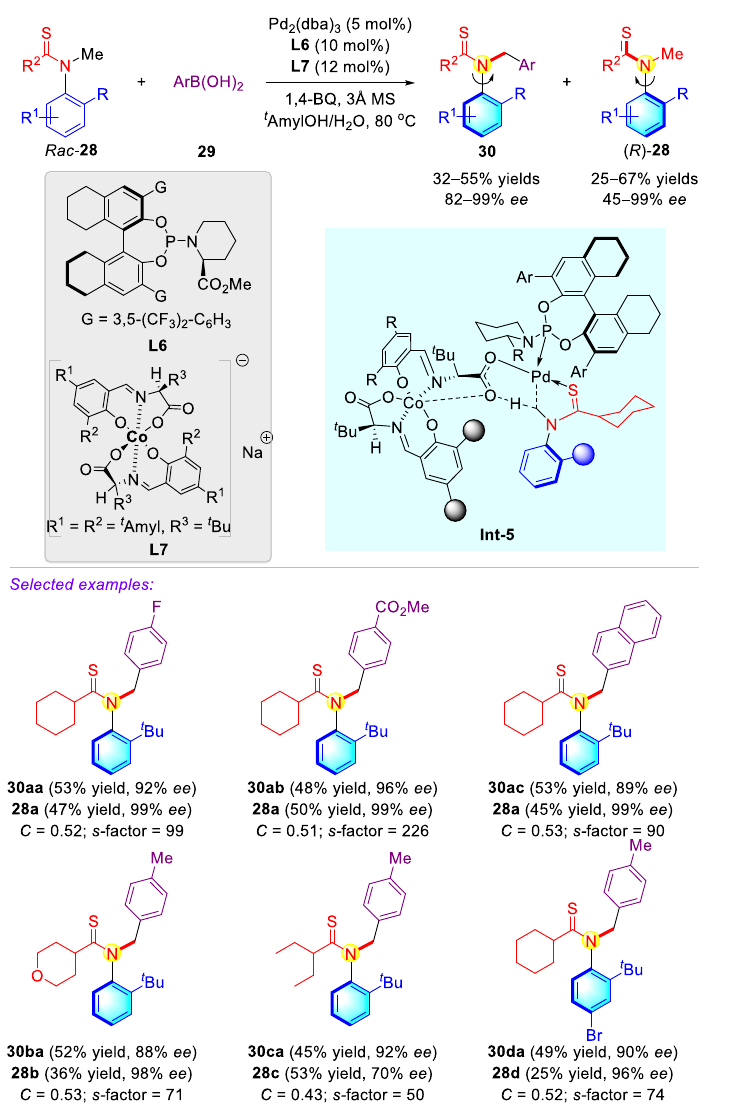
Scheme 9. Atroposelective C(sp 3 ) – H coupling for the kinetic resolution of thioanilide